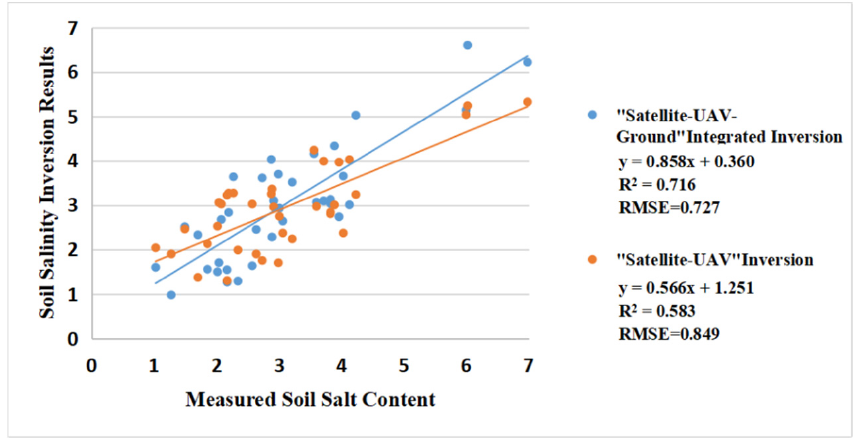
Figure 10. Scatter plots of measured sample points and soil salinity inversion results by two methods in Kenli District.